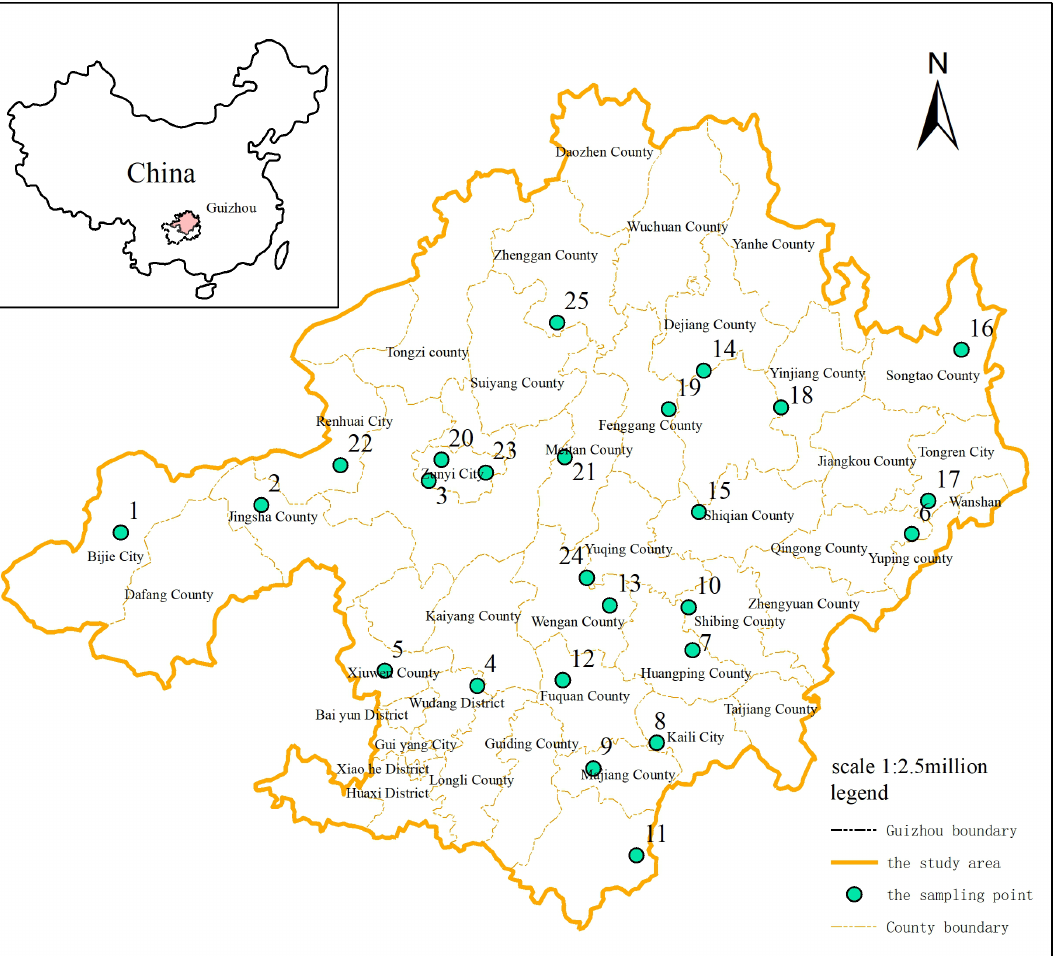
Figure 1. Map of the distribution of sampling locations in the study area of Guizhou,